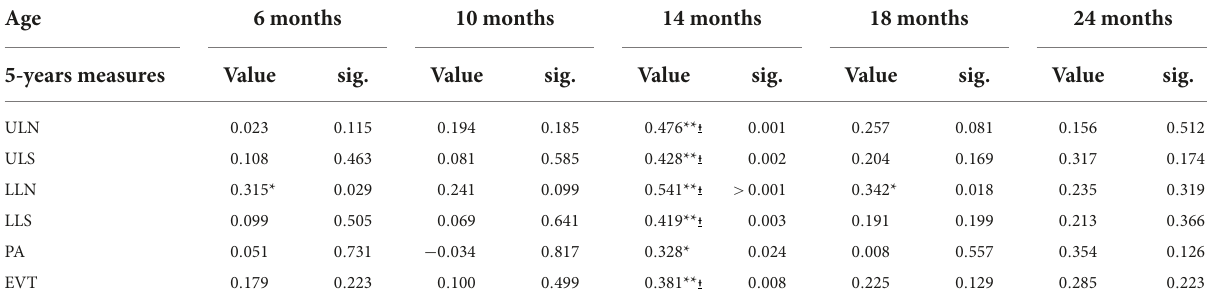
TABLE 3 Correlations between PT (parentese) at 6–24-months and reading-related measures at 5-years of age for the entire sample of 53 participants.